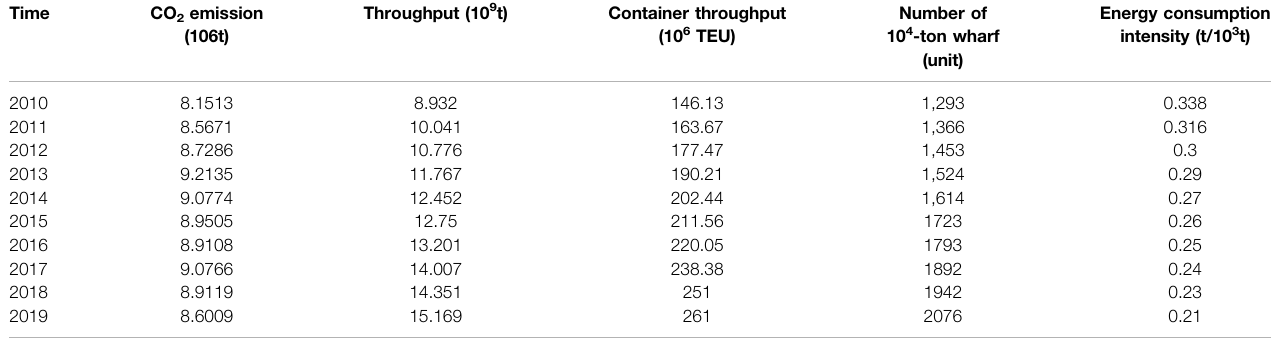
TABLE 1 | The data of Chinese ports. Time CO 2 emission